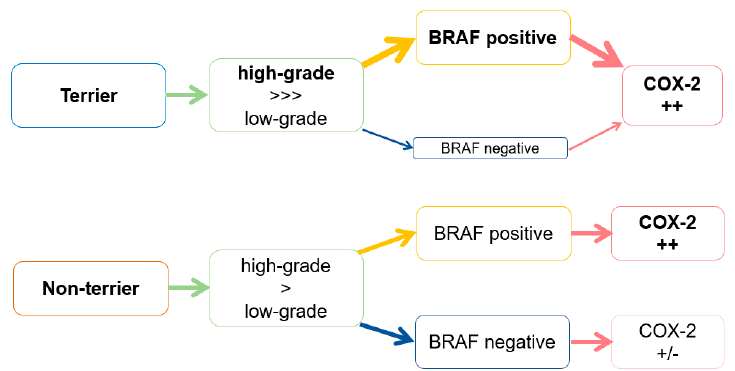
Figure 7. Interpretation algorithm for BRAF mutation in terriers and non-terrier breeds in correlation with the histological grade and cyclooxygenase-2 expression.